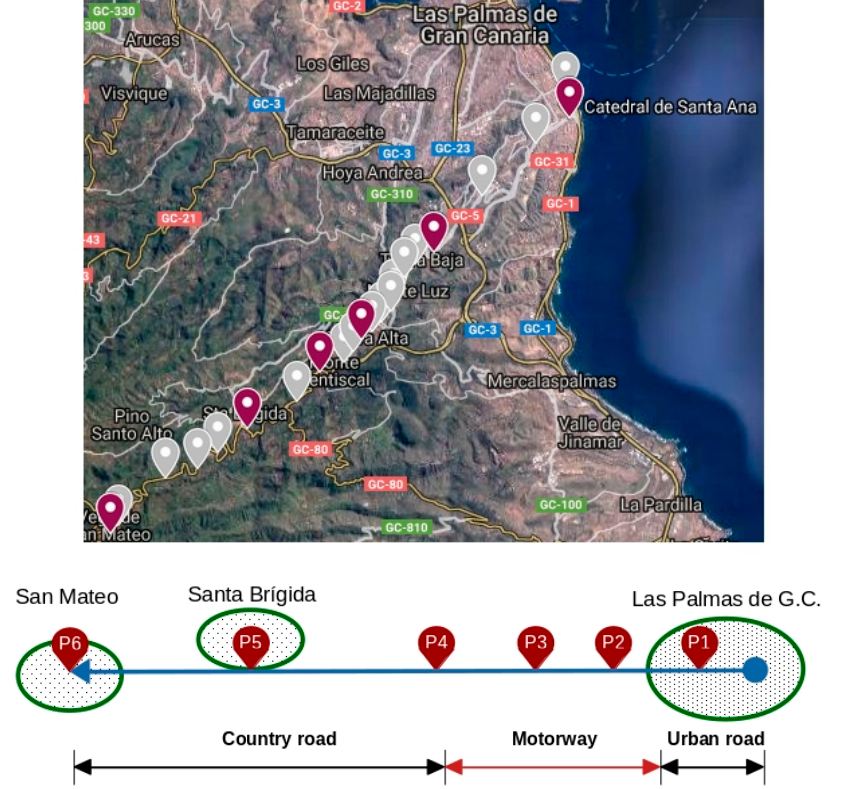
Figure 2. Route and stops of the analyzed